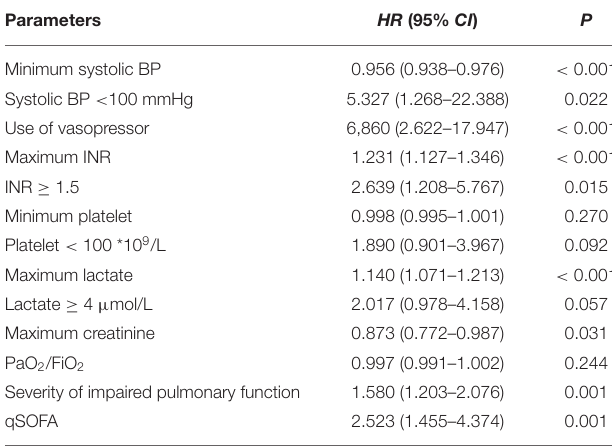
TABLE 3 | Univariate Cox analysis of factor related to hospital mortality in patients with sepsis received CRRT.